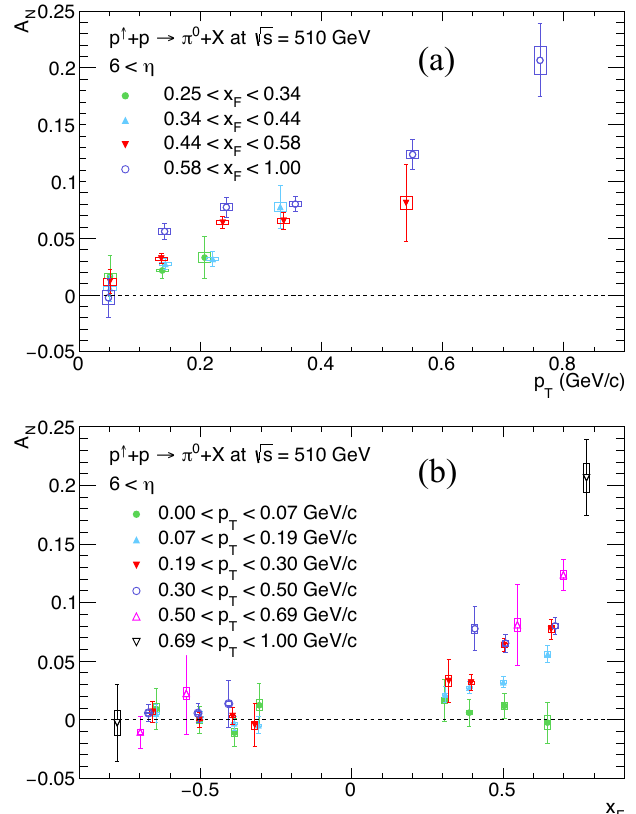
Figure 3: A of the very forward π 0 s as functions of (a) p N and (b) x for several p ranges. Only forward A F T bars represent the statistical uncertainties, and the boxes represent the systematic